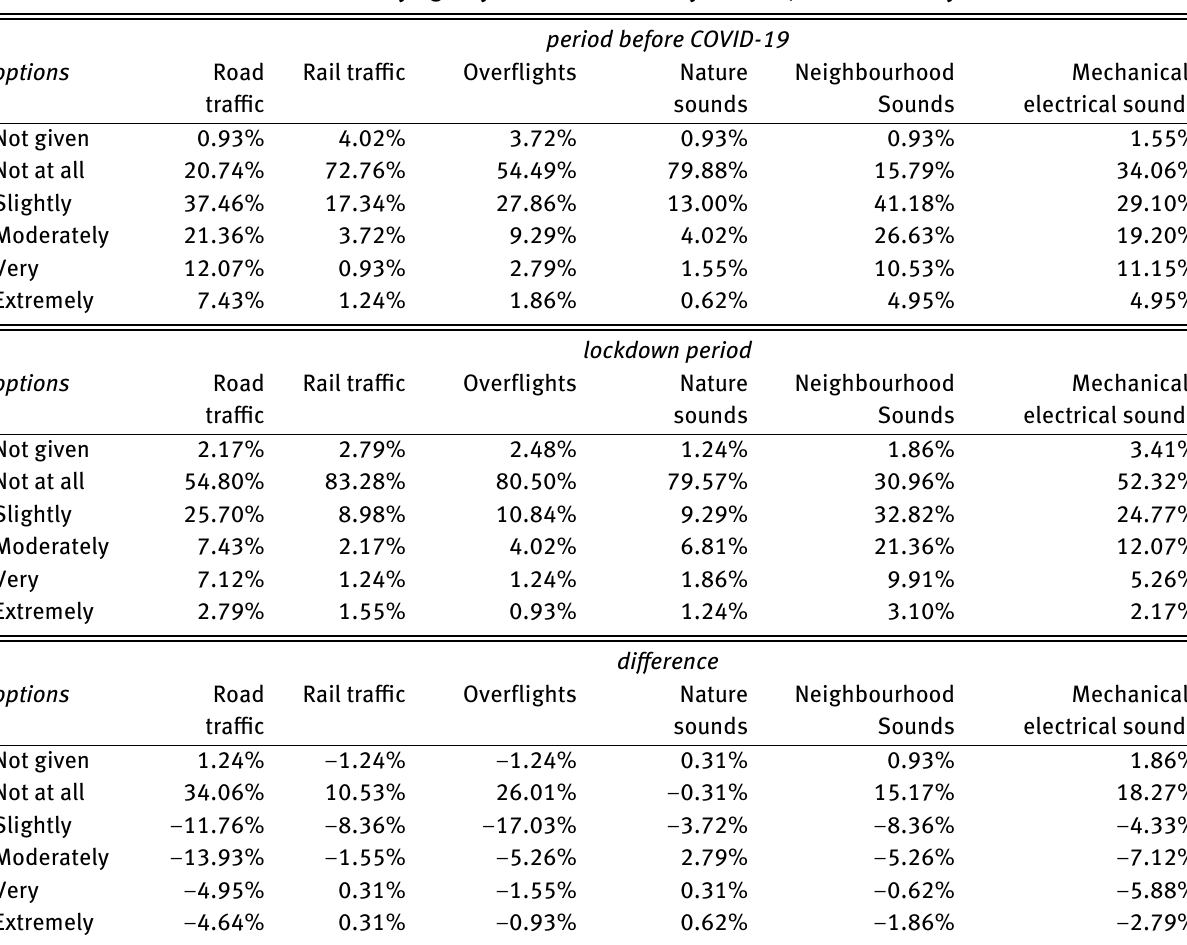
Table 12: Comparison between the lockdown period and the period before COVID-19 emergency regarding the type the sounds subjects heard from their home and considered as annoying How annoying do you find the sounds you could/can hear from your home?